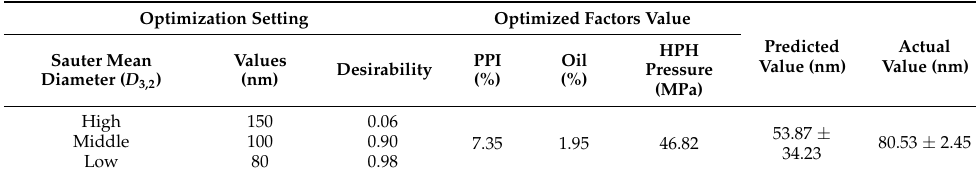
Table 2. The optimization setting, optimized factor values, predicted value, and actual value for pea protein isolate (PPI)-stabilized